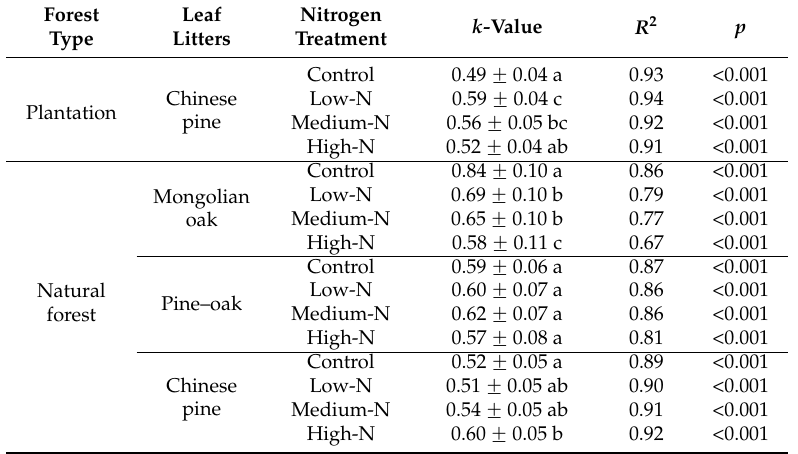
four N addition